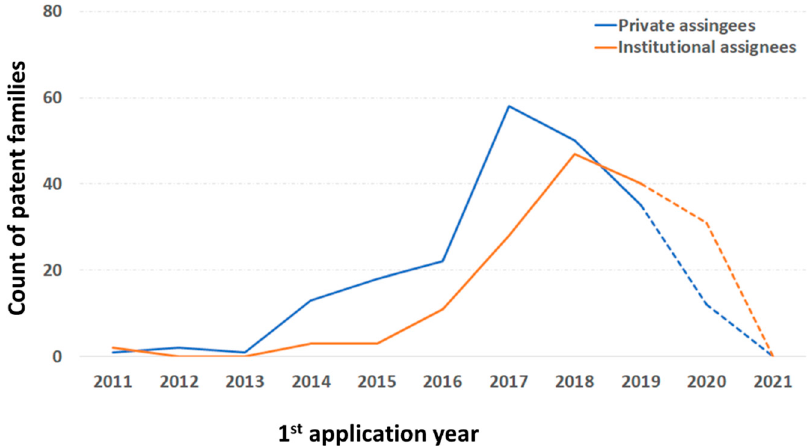
Figure 13. Count of patent families vs. first patent application year around the lines of FFF adapted